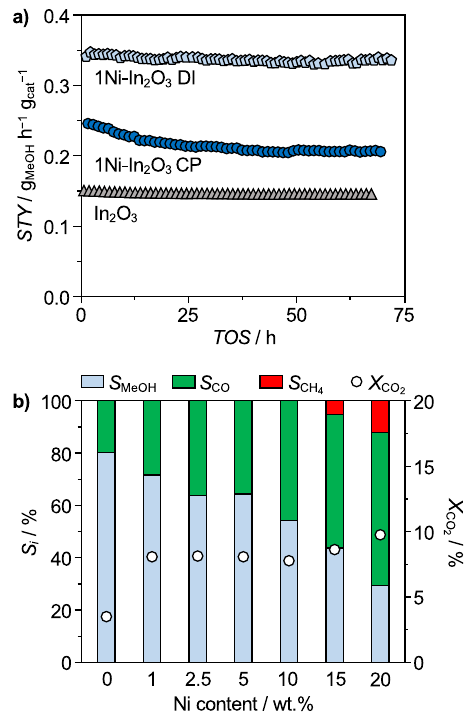
Fig. 1 Catalytic performance of nickel-promoted In 2 O 3 catalysts. a Space- time yield ( STY ) of methanol as a function of time-on-stream ( TOS ) over Ni-In 2 O 3 containing 1 wt.% of nickel incorporated by dry impregnation (DI) and coprecipitation (CP) and unpromoted In 2 O 3 as a reference. b CO 2 conversion and product selectivity of catalysts produced by DI as a function of the nominal nickel content on In 2 O 3 . Reaction conditions: T = 553 K, P = 5 MPa, molar H 2 :CO 2 = 4, and WHSV = 24,000 cm STP 3 h − 1 g cat − 1